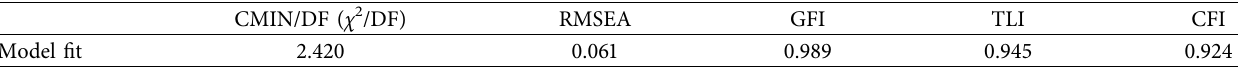
Table 8: Model fit summary.